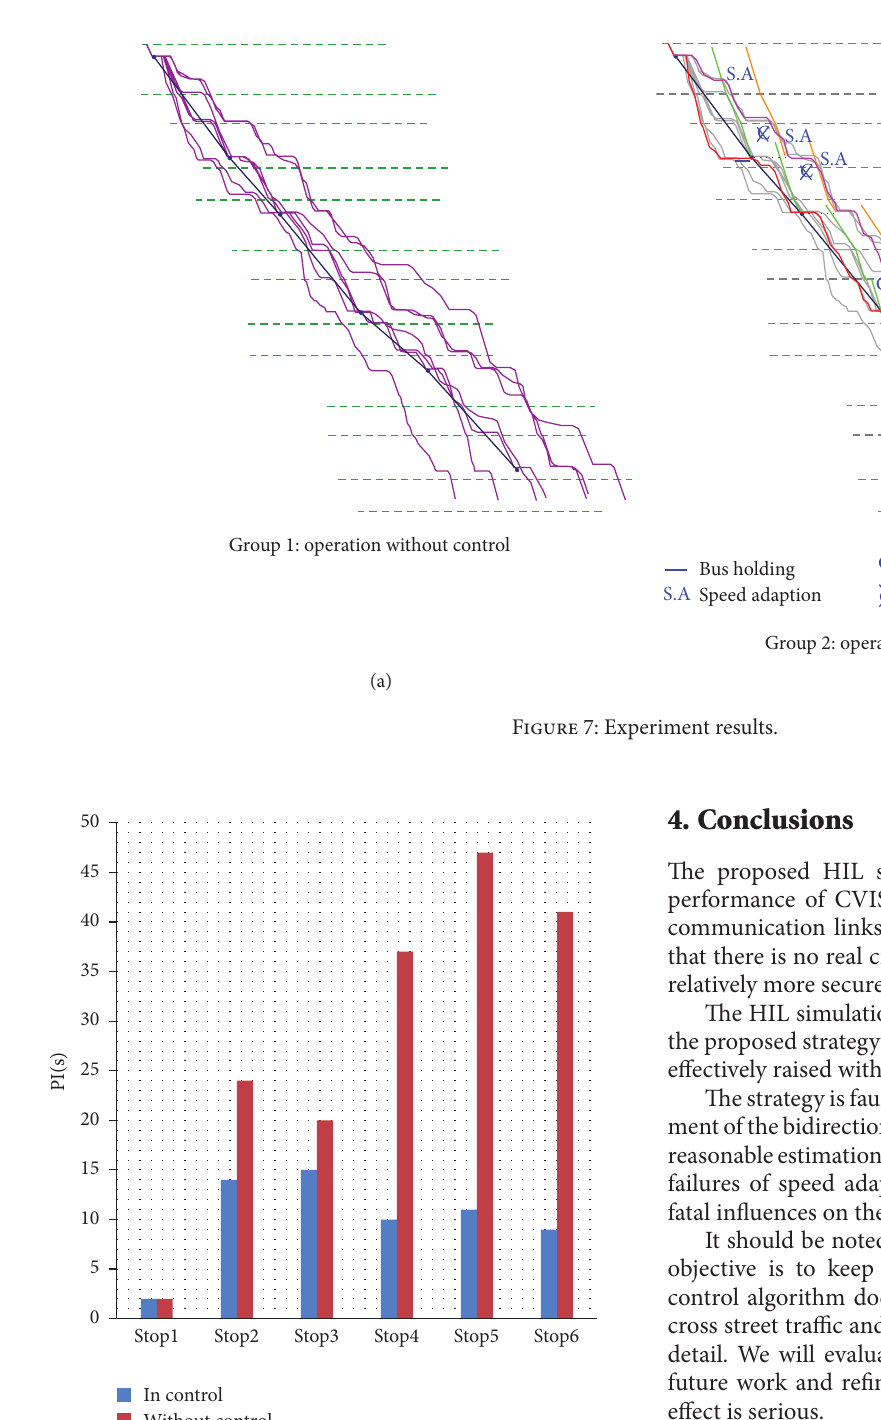
Figure 8: Punctuality index PI(s) in each stop.